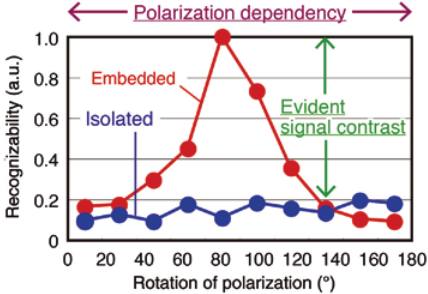
Figure 6: Experimentally obtained recognizability R ing to the embedded nanoscale structure (red circles) and isolated nanoscale structure (blue circles). Source: Adapted with permission from The Optical Society: Optics Express